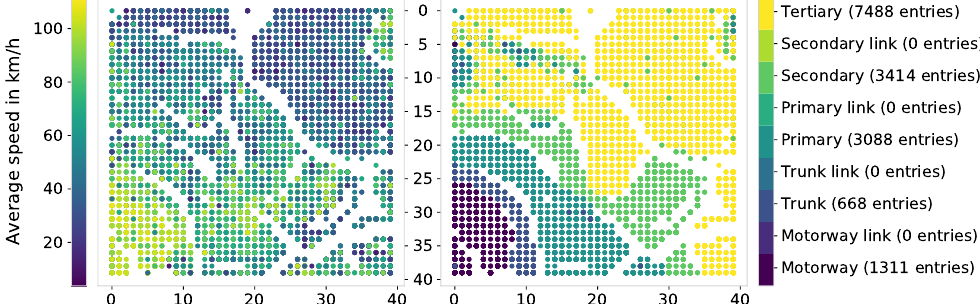
Figure 9. Visualization of the average speed values ( left ) and the dominant road classes ( right ) per SOM node on the grid of the unsupervised SOM for the BM dataset. The color white is used if no datapoint is mapped to a SOM node.